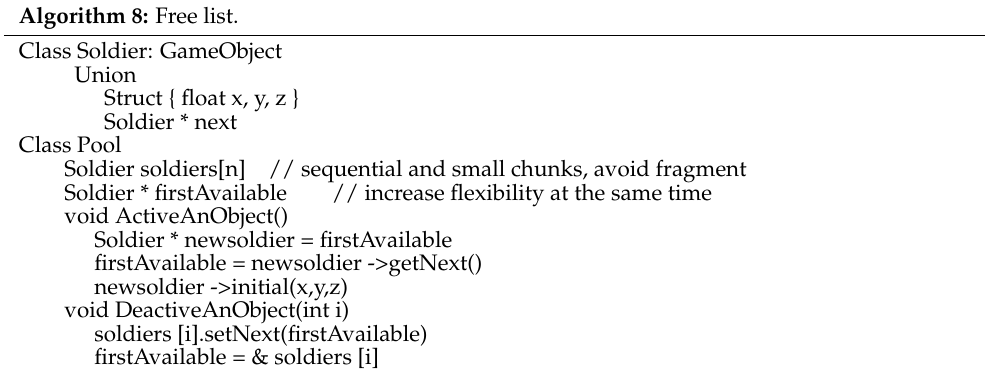
Algorithm 8: Free list. Class Soldier: GameObject